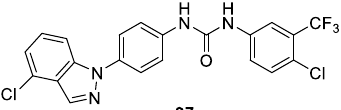
Figure 12. Chemical structure of N -(4-(1-(4-chlorineindazole))phenyl)- N -(4-chloro-3–trifluoro-methyl phenyl) urea 97.